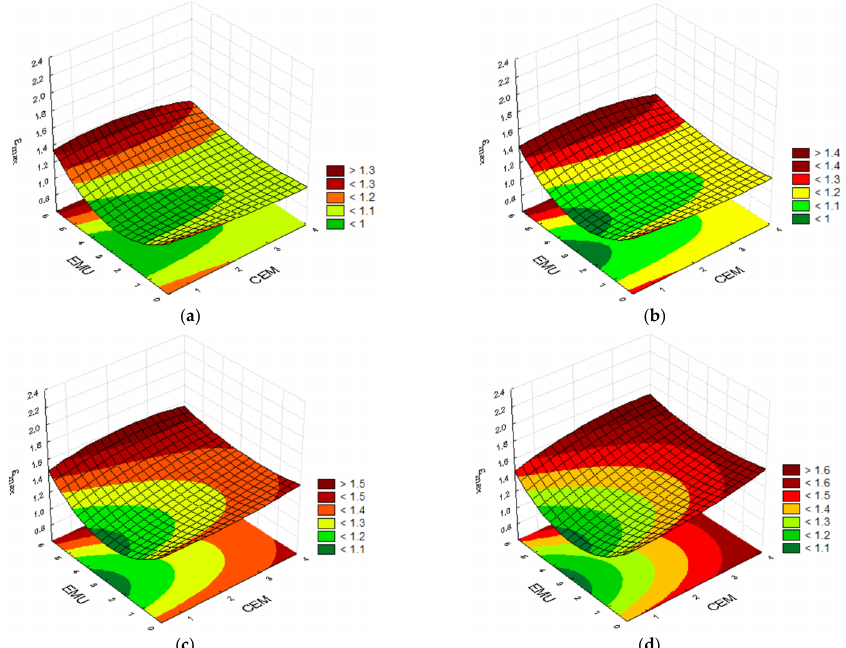
Figure 4. Plots for the strain at maximum force ε max at the temperature of 0 °C, taking into consideration the cement and bitumen emulsion contents and the polymer modifier content of ( a ) 0.0%; ( b ) 0.5%; ( c ) 2.0%; and ( d ) 3.5%. The convergence surfaces depict the properties of the mineral–cement mixtures containing bitumen emulsion and polymer modifier. All plots demonstrate the dependence of the impact of cement and bitumen emulsion on the strain at maximum force ε max at a constant polymer content at the temperature of 0 °C. A traditional mineral– cement–emulsion mixture is considered for 0.0% modifier content in the mixture. In such a case, the best results are obtained at the maximum emulsion content in the mixture. Similar results are obtained for the mixture containing 0.5% of polymer modifier. An increase in the recycled mixture’s polymer content to 2.0% and 3.5% allows us to obtain high strain at maximum force results with a simultaneous reduction in the emulsion content. It is therefore advantageous to slightly increase the percentage share of cement in the mixture. The mixtures’ working nature changes when the temperature is increased to 20 °C. The mixture containing 2.0% of cement, 3.5% of polymer modifier, and 5.0% of bitumen emulsion achieved one of the highest strain results. The case was similar during the test conducted at 0 °C. On the other hand, the highest strain ε max = 2.22 was achieved by the recycled mixture containing 0.5% of modifier, 3.5% of cement, and 2.5% of bitumen emulsion. The results for the mixture containing 2.0% of cement, 0.5% of polymer, and 0.0% of emulsion with the ε max = 1.61, as well as the mixture containing 0.5% of cement, 2.0% of polymer, and 5.0% emulsion where ε max = 1.67, are also interesting. This exemplifies the impact of the binder composition optimisation and the polymer content on the mixture’s parameters. Due to the fact that the test was conducted at 20 °C, the mixtures became less stiff, and demonstrated higher susceptibility and higher strain at maximum force. Figure 5 below presents the convergence surfaces at 20 °C.